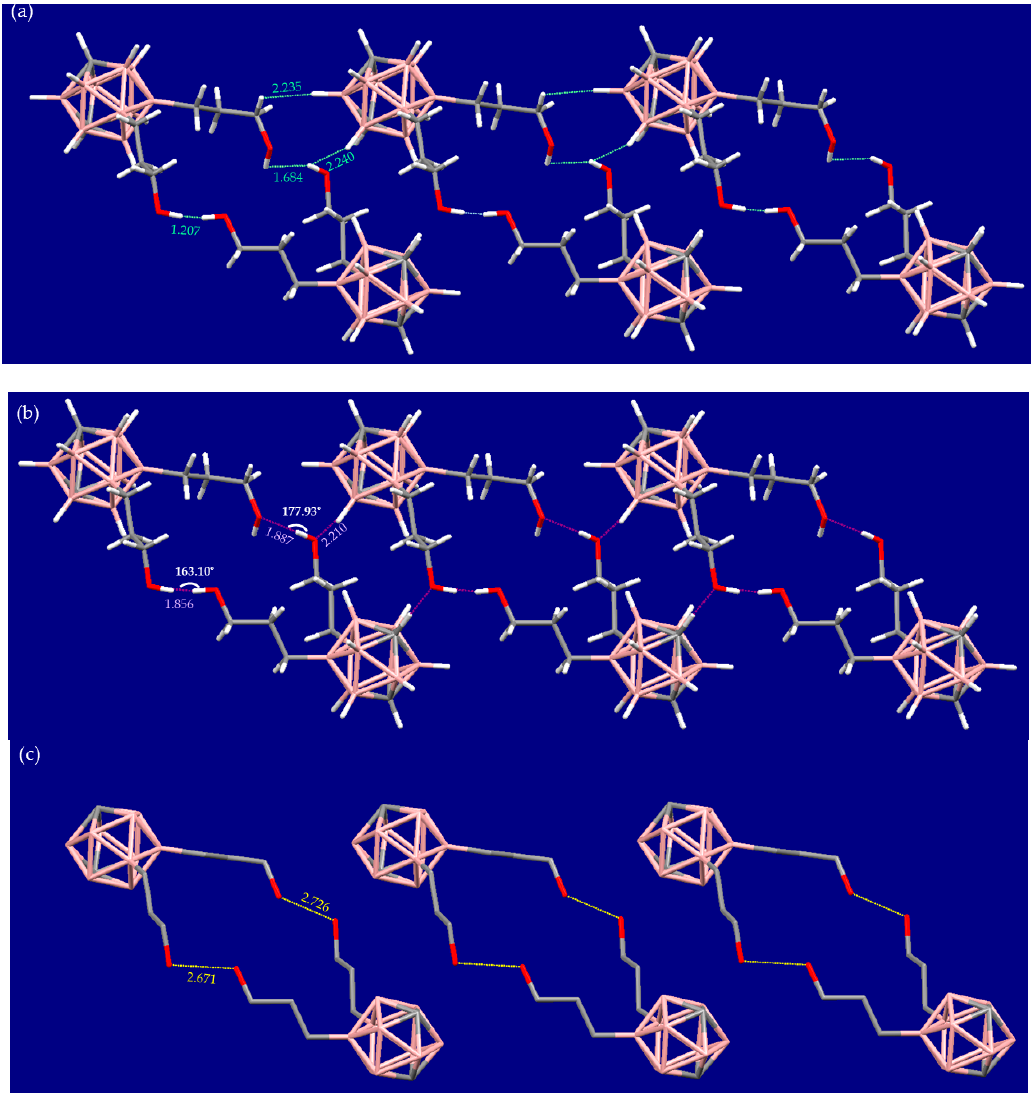
Figure 6. Network presentation of 4 showing all intermolecular contacts as dashed lines: ( a ) H … H, ( b ) O … H and ( c ) O … O (H are omitted for clarity).